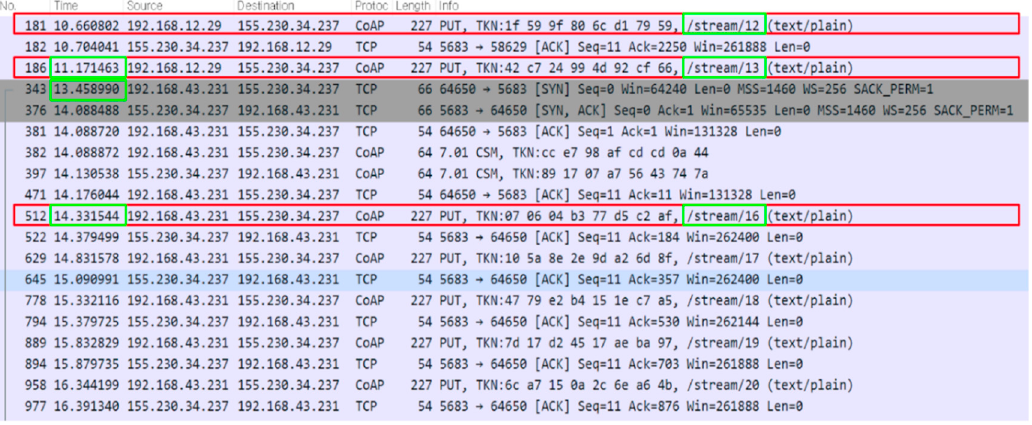
Figure 9. Drawback of TCP three-way handshaking mechanism.